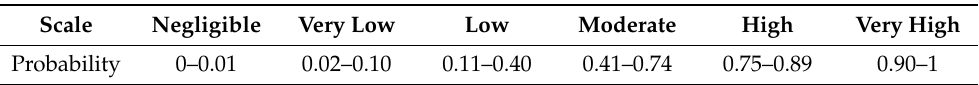
Table 2. Scale for likelihood and consequence estimation used for calculating the risk of identified hazards with the endpoint of causing more